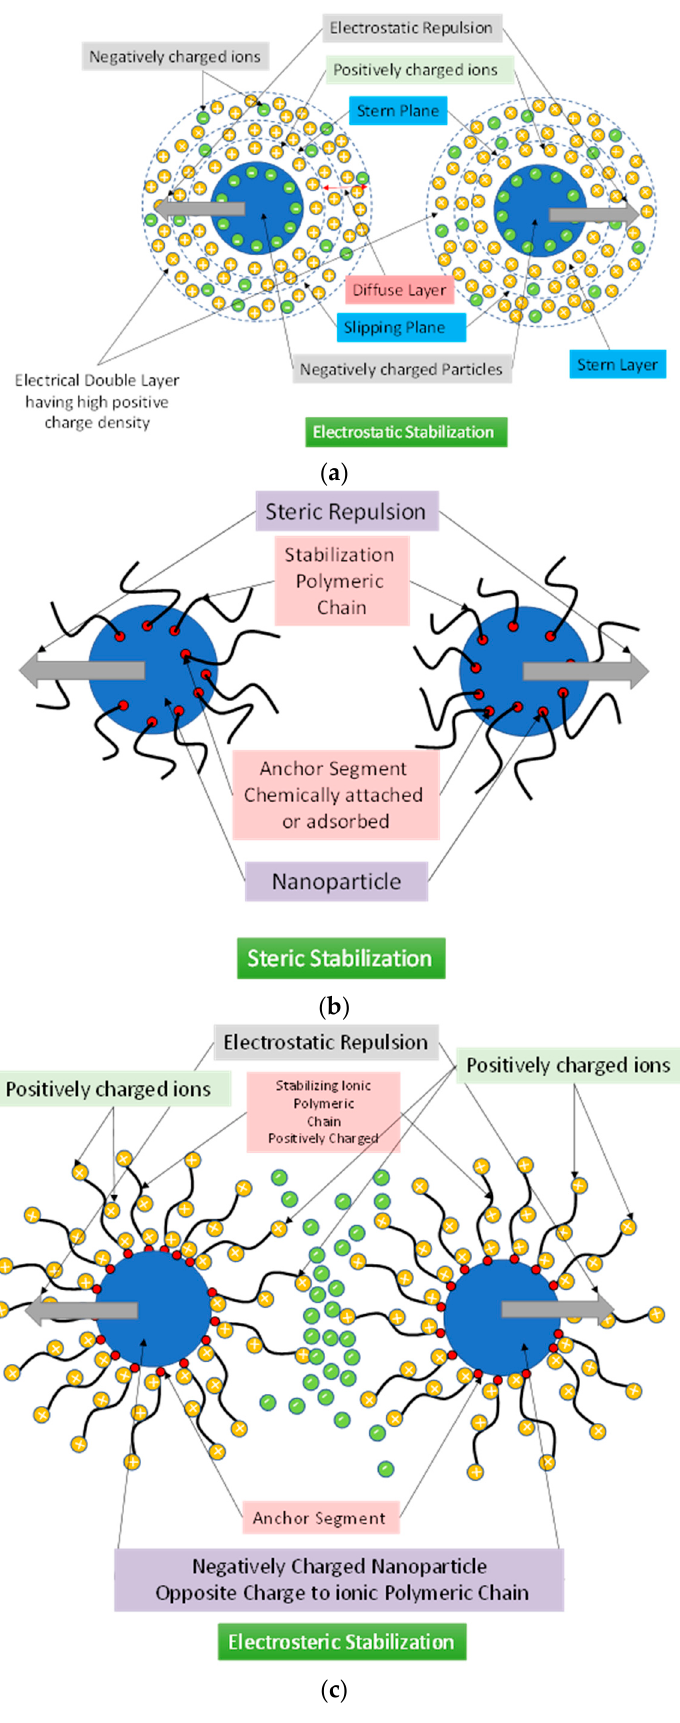
Figure 7. Schematic representation of electrostatic ( a ), steric ( b ), and electrosteric ( c ) stabiliza- tion